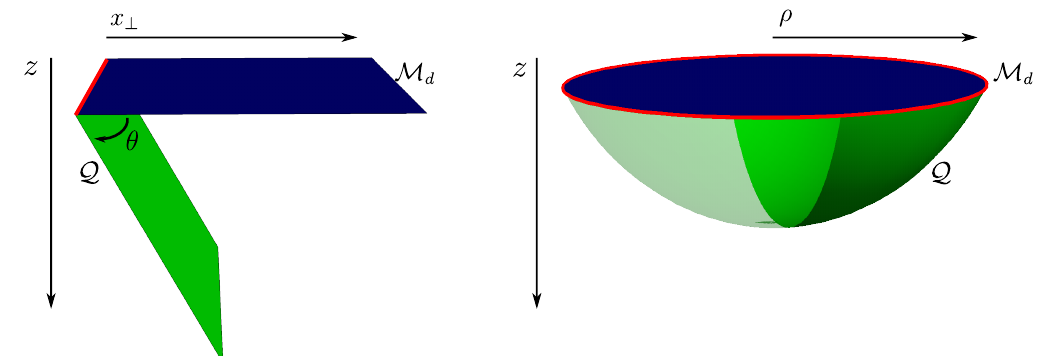
Figure 6 . The holographic space dual to the BCFT. The BCFT is defined on the manifold M d , depicted in blue, and its boundary is represented by the red curve. The green surfaces correspond to the end-of-the-world brane Q . Left: BCFT on half space in the vacuum state, with BCFT boundary at x ⊥ = 0 and angle θ between Q and M d . Right: BCFT on a ball in the vacuum state, with BCFT radial coordinate ρ